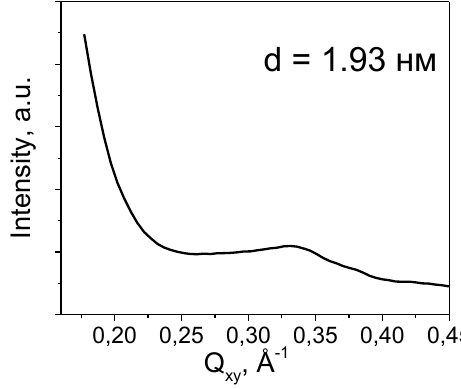
Fig. 3. GID curve of the floating layer of compound I.